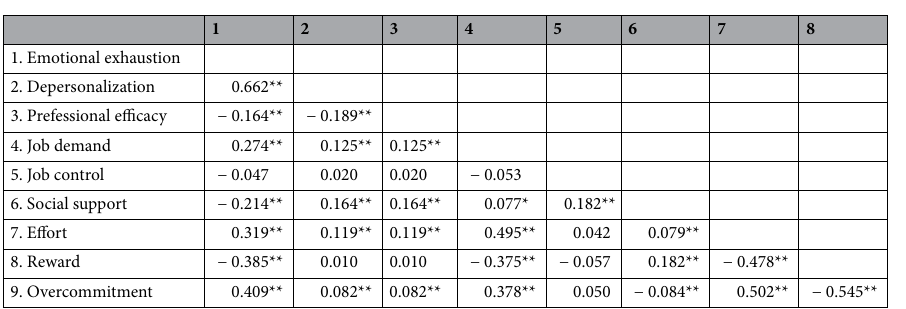
Table 3. Correlations among the dimensions of the MBI-GS, JCQ and ERI scores. * P < 0.05, ** P <